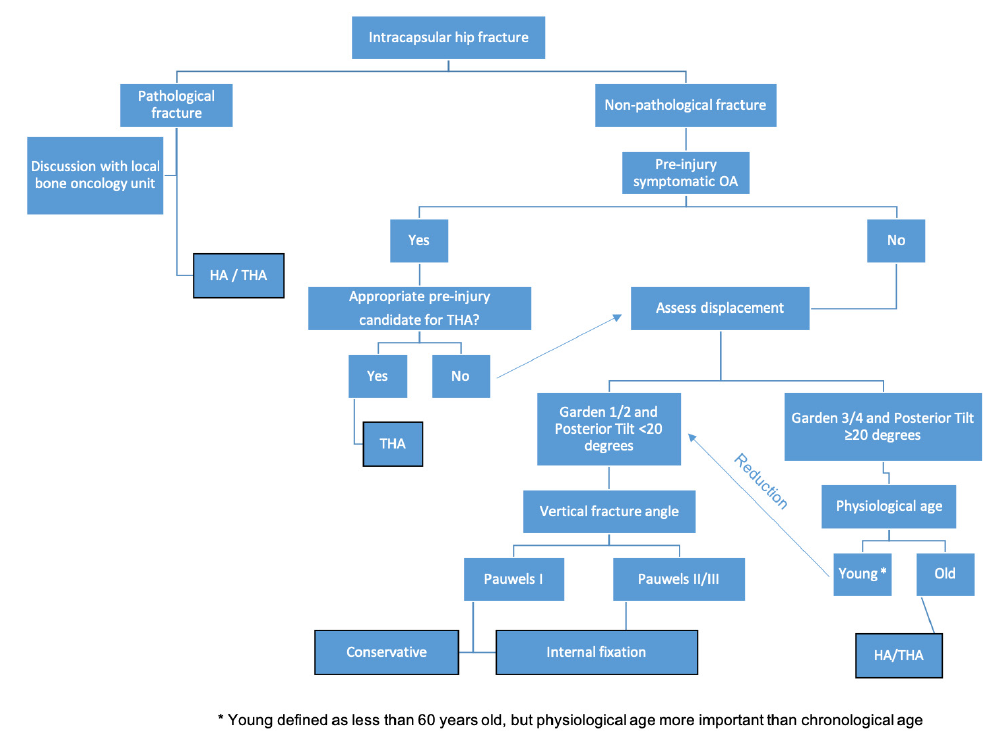
Figure 1. Surgical algorithm for intracapsular femoral neck